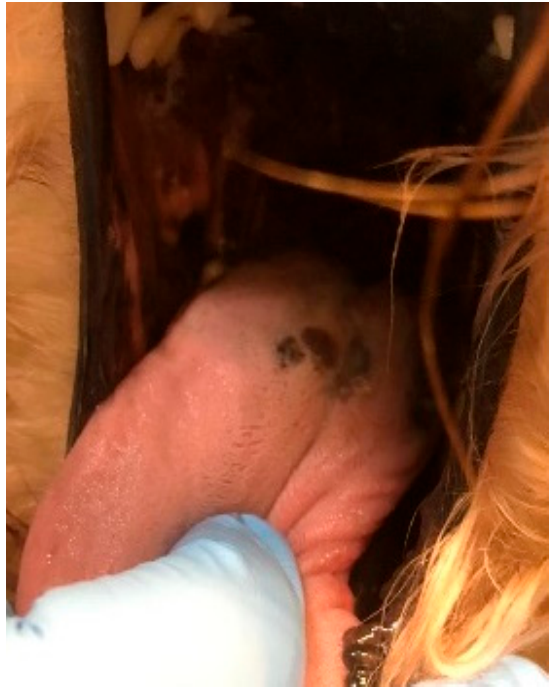
Figure A2. Appearance of the mass at the end of immunotherapy.